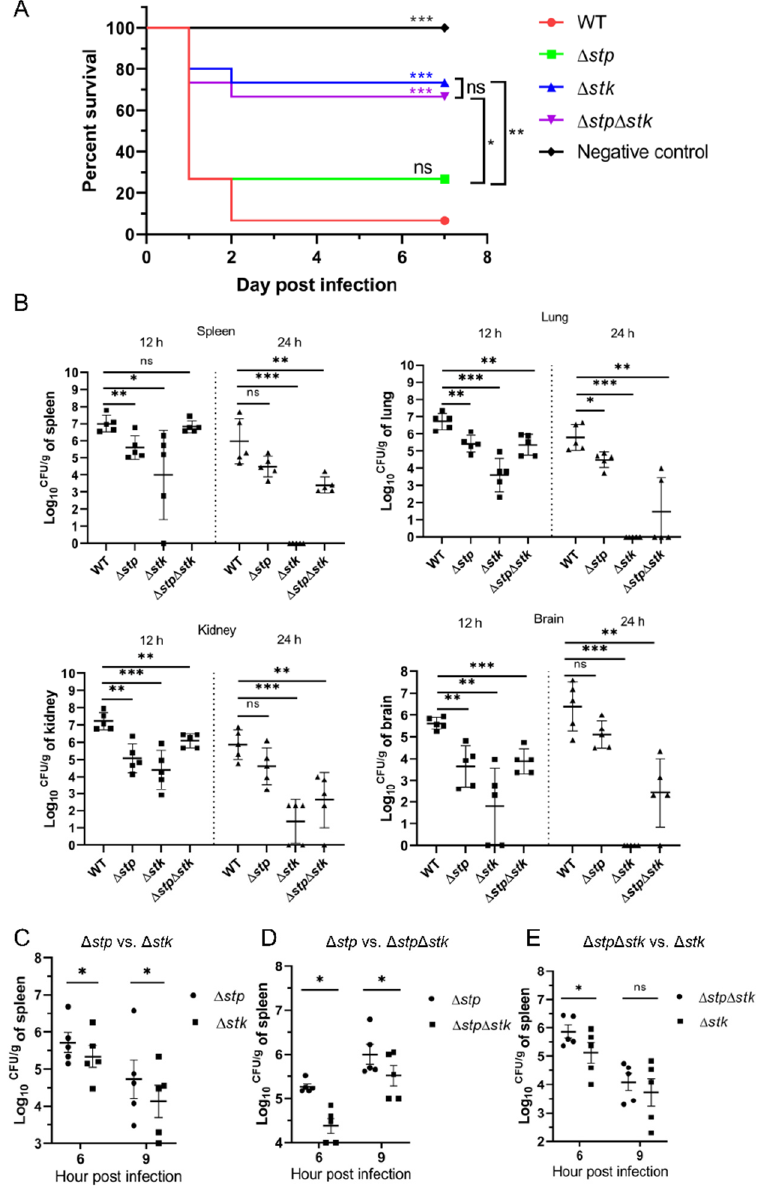
Figure 2. Virulence evaluation of the ∆ stp , ∆ stk , and ∆ stp ∆ stk strains. ( A ) Mouse survival assay. Mice were intraperitoneally injected with 8 × 10 8 CFU of WT, ∆ stp , ∆ stk , or ∆ stp ∆ stk , respectively, and PBS was used as a negative control. Significant differences in survival rates between different groups were analyzed by the log-rank (Mantel-Cox) test. Fifteen mice were used in each group. ( B ) Bacterial colonization assay. Mice were intraperitoneally injected with 9 × 10 7 CFU of WT, ∆ stp , ∆ stk , or ∆ stp ∆ stk , respectively. Mice were euthanized at each indicated time point. The spleen, lung, kidney, and brain were collected, resuspended in PBS, homogenized, and plated on TSA plates for colony enumeration. Five mice were used in each group. Data are presented as the mean ± standard deviations. Statistical significance is determined by two-tailed, unpaired Student’s t -tests (ns, p value > 0.05; *, p value < 0.05; **, p value < 0.01; ***, p value < 0.001). ( C – E ) Competitive infection assay. Mice were infected with a 1:1 mixture of ∆ stp and ∆ stk ( C ), ∆ stp and ∆ stp ∆ stk ( D ), or ∆ stp ∆ stk and ∆ stk ( E ). Spleens were collected, resuspended in PBS, homogenized, and plated on TSA plates for colony enumeration. Five mice were used in each group. Statistical significance was determined by two-tailed, unpaired Student’s t -tests (ns, p value > 0.05; *, p value <